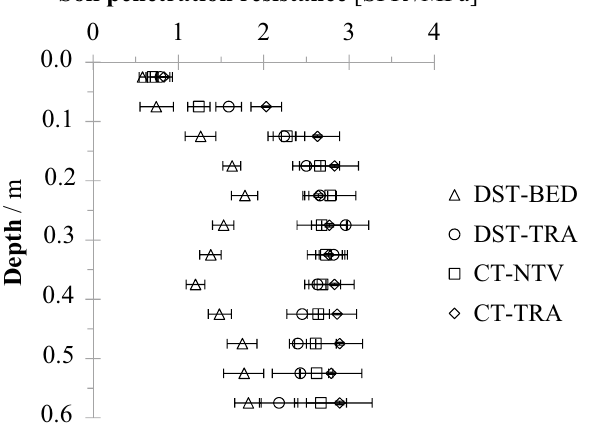
Figure 2. Soil penetration resistance as a function of depth for deep strip tillage bed with no traffic (DST-BED), deep strip tillage traffic lane (DST-TRA), conventional tillage no traffic lane (CT-NTV), and conventional tillage traffic lane (CT-TRA) in a Rhodic Kandiudox. If confidence intervals do not overlap, the differences are significant (p ≤